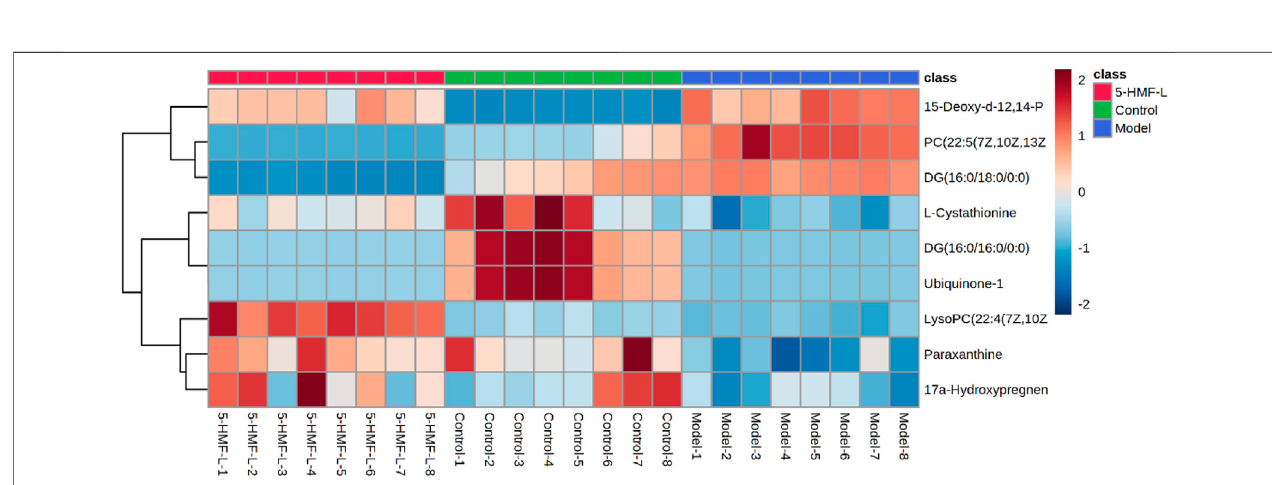
FIGURE 8 | Cluster analysis heatmap of different metabolites in BDS rat plasma. Brown and blue represent higher and lower than average levels of different metabolites, respectively. The rows represent different metabolites, and the columns represent rat plasma samples ( n (cid:1) 8).